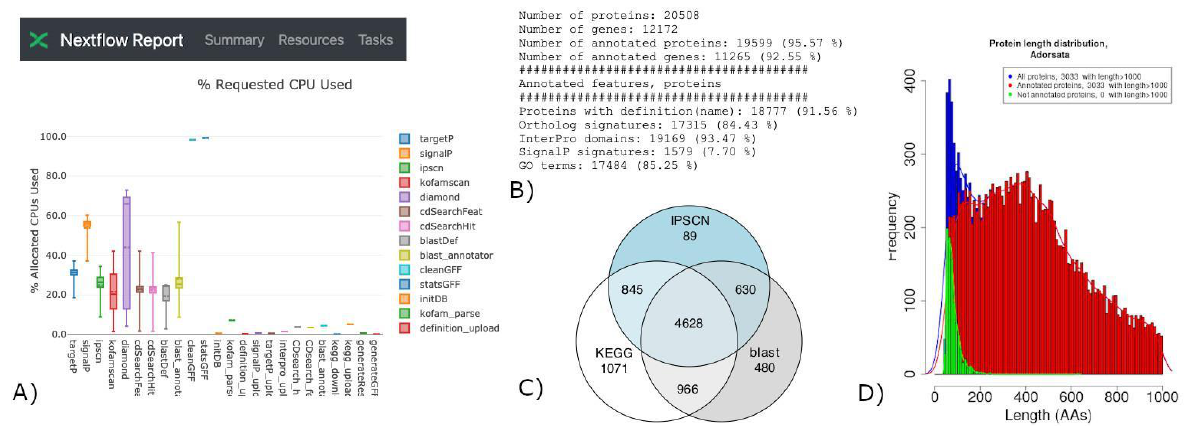
Figure 3. FA-nf annotation run results on Apis dorsata . ( A ) Example of NF report; ( B ) example of annotation summary; ( C ) proteins annotated with GO terms by annotation sources; ( D ) length distributions for annotated and unannotated proteins.